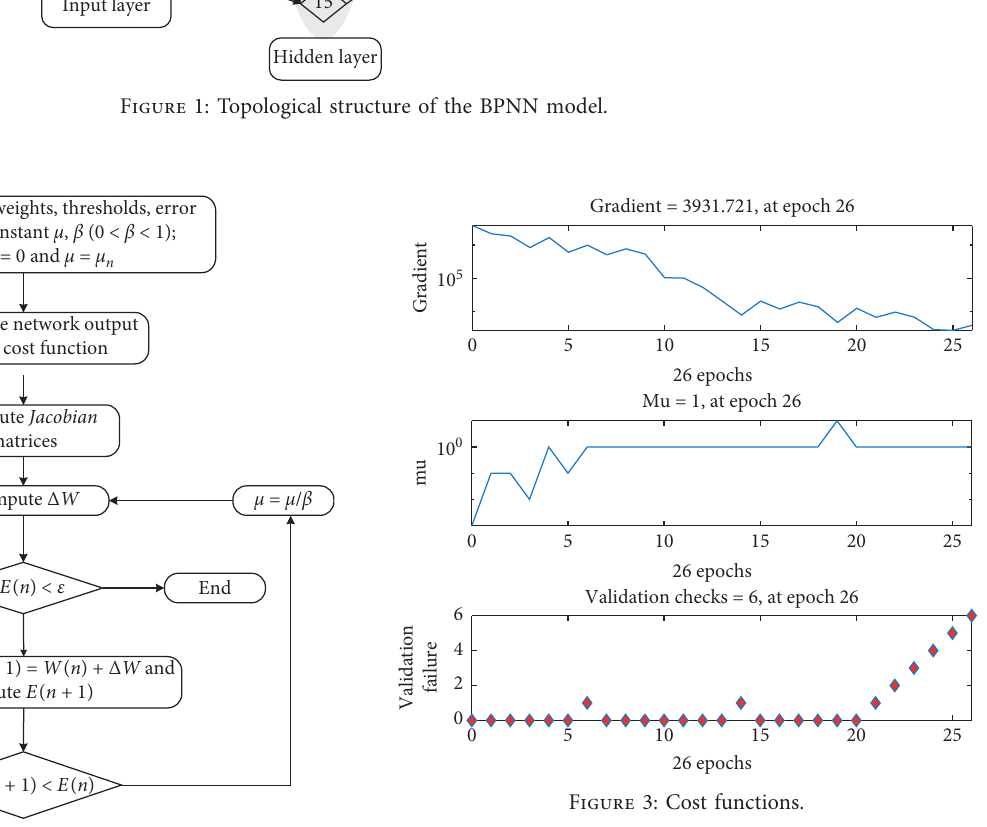
Figure 2: The BPNN model algorithm flowchart.